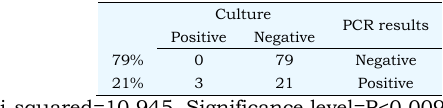
Table 3 Correlation coefficients between culture and PCR